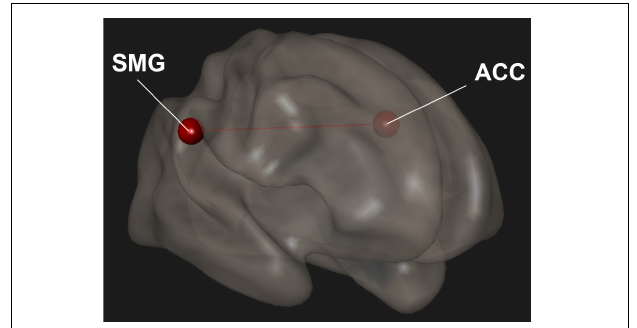
FIGURE 4 | In meditators completing surveys, changes in mindfulness scores were correlated with changes in functional connectivity. There was increased functional connectivity between the anterior cingulate cortex (ACC) and supramarginal gyrus (SMG). Red indicates increased connectivity and blue indicates decreased connectivity.